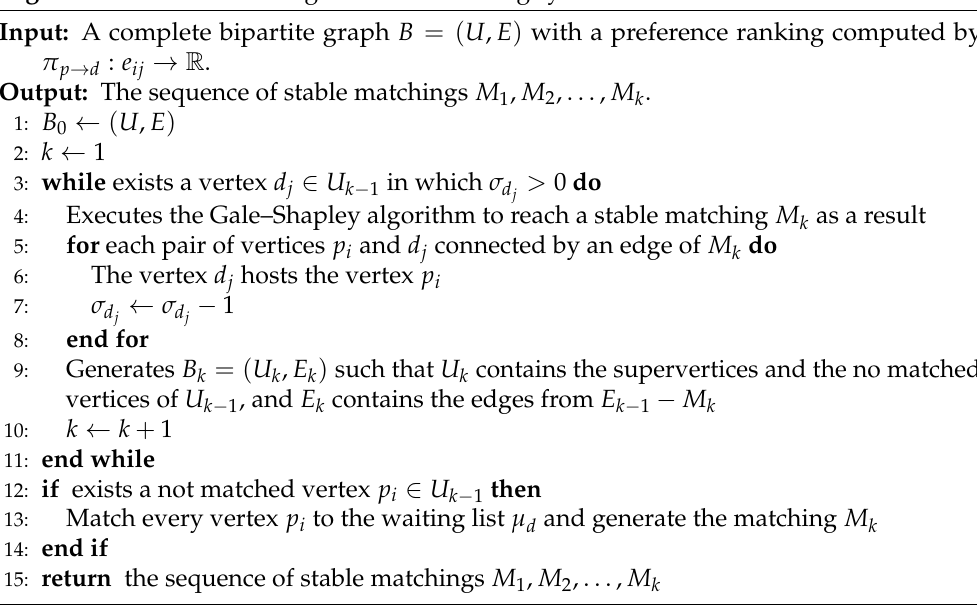
Algorithm 1 Stable matching for the ridesharing